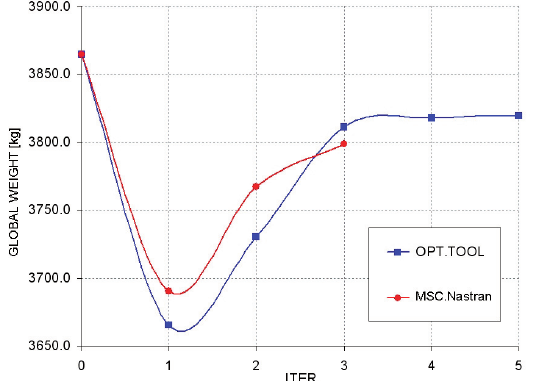
Fig. 7. Result comparison of the global weight on a space